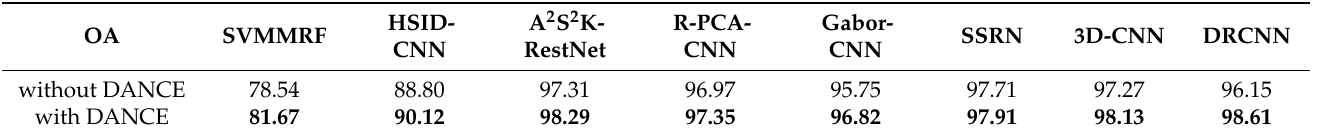
Table 9. Comparison of the classification accuracy (%) among the proposed method and the baselines on the Indian Pines